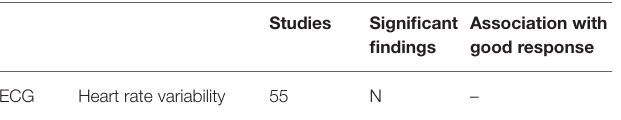
TABLE 7 | Results from cardiac studies.